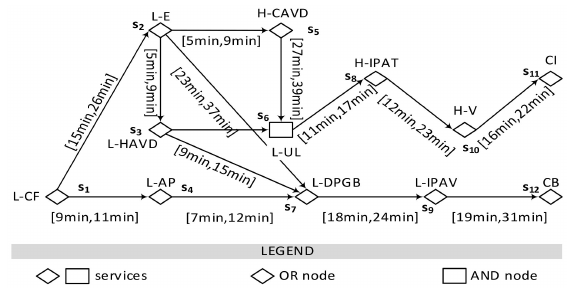
Figure 3. An example of Proactive Data Service Graph